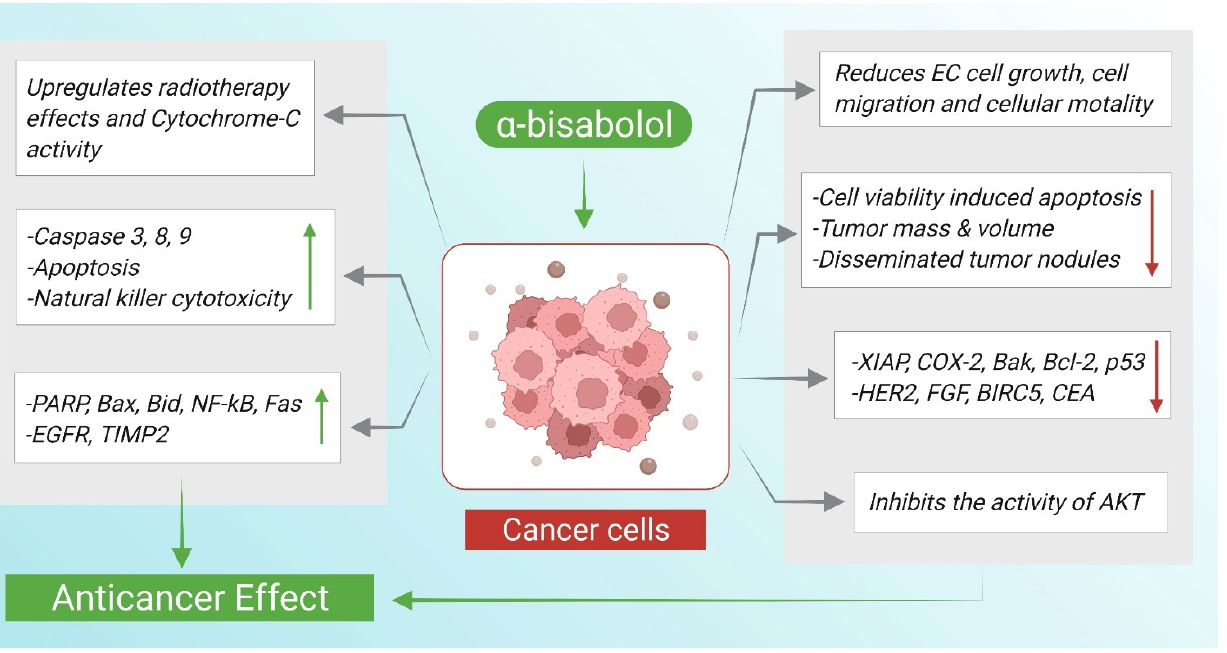
Figure 3. α‐ Bisabolol mediated anticancer actions and demonstrated mechanisms.  ; increase,  ;decrease.